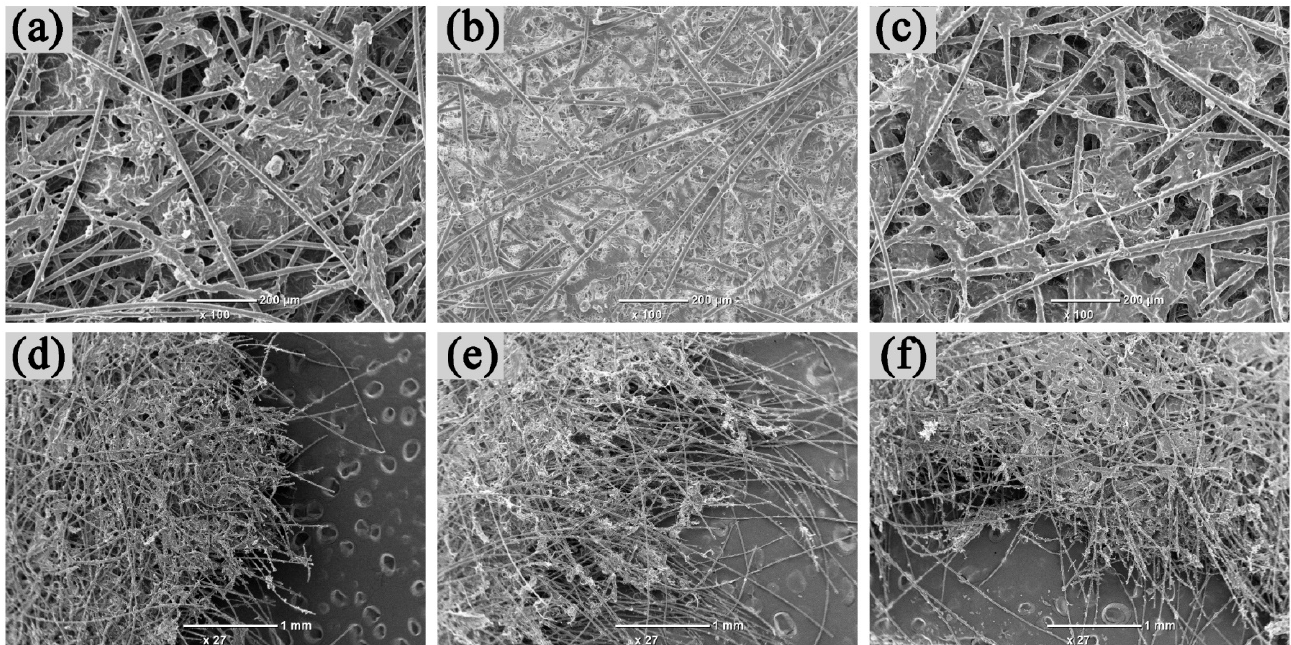
Figure 5. Surface and fracture surface morphology of different resin impregnated paper-based composites: ( a ) Epoxy impregnated material surface, ( b ) Modified epoxy resin impregnated material surface, ( c ) Ternary resin impregnated material surface, ( d ) Epoxy impregnated material fracture surface, ( e ) Modified epoxy resin impregnated material fracture surface, ( f ) Fracture surface of ternary resin impregnated